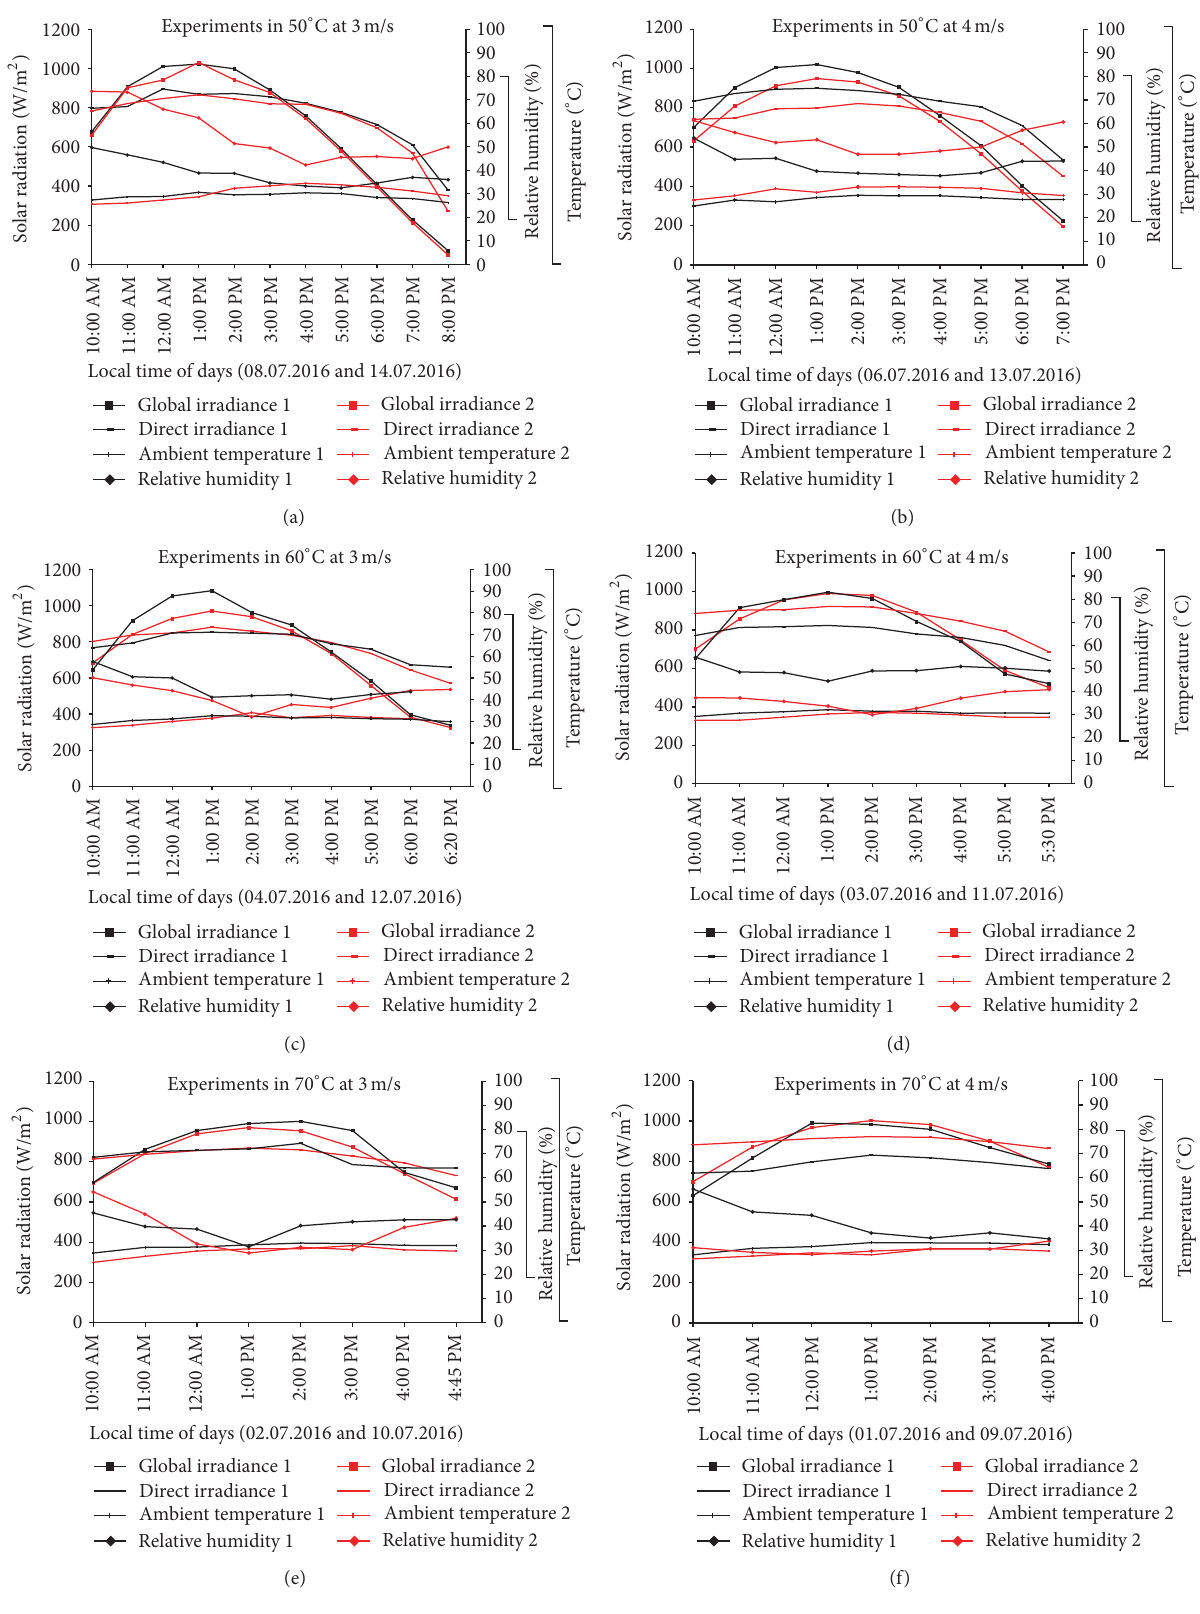
Figure 3: Climatic data of experimental dates (black and red lines are symbolize the 1st and 2nd dates,